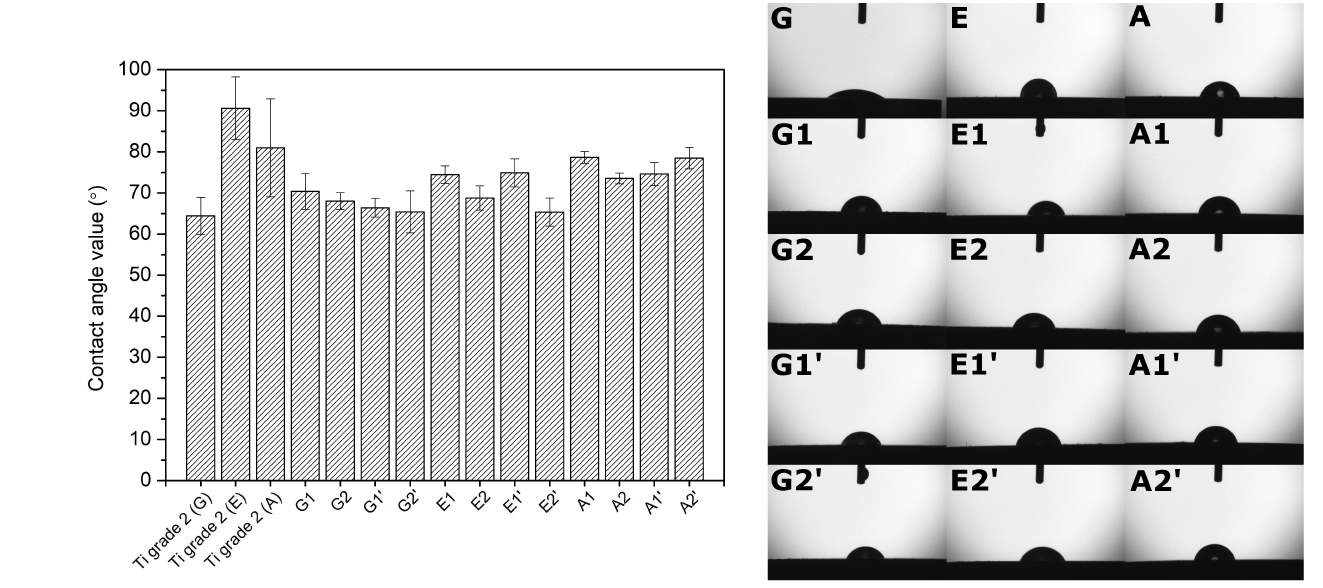
Figure 6. The results of the water contact angle measurements for the surface of pre-treated Ti grade 2 substrates and the modified substrates with chit/EE100 coatings obtained for different process parameters. Data are presented as the mean ± SD (n =